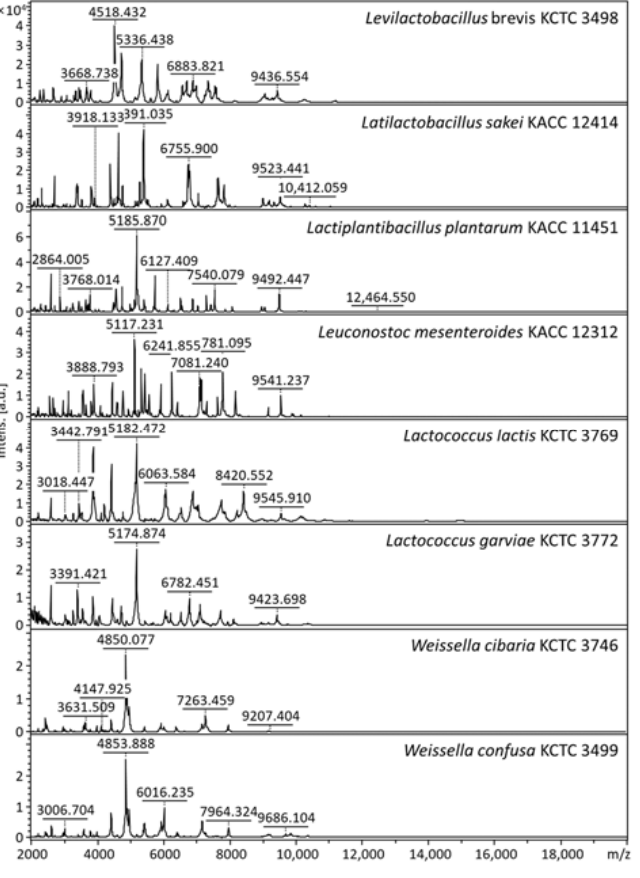
Figure 4. MALDI-TOF MS spectra of LAB mainly involved in kimchi fermentation; m/z , mass-to-charge ratio; a.u., arbitrary units.